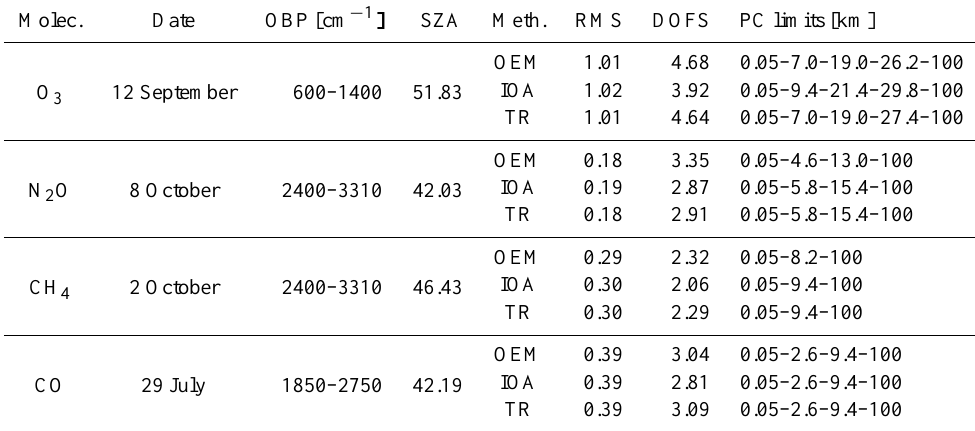
Table 3. Date, OBP and SZA of the reference spectra for O 3 , N 2 O, CH 4 and CO measured at Ile de La R´eunion in 2007, together with the RMS of the fit residual, DOFS and independent PC limits when using the OEM, IOA and TR. Molec.